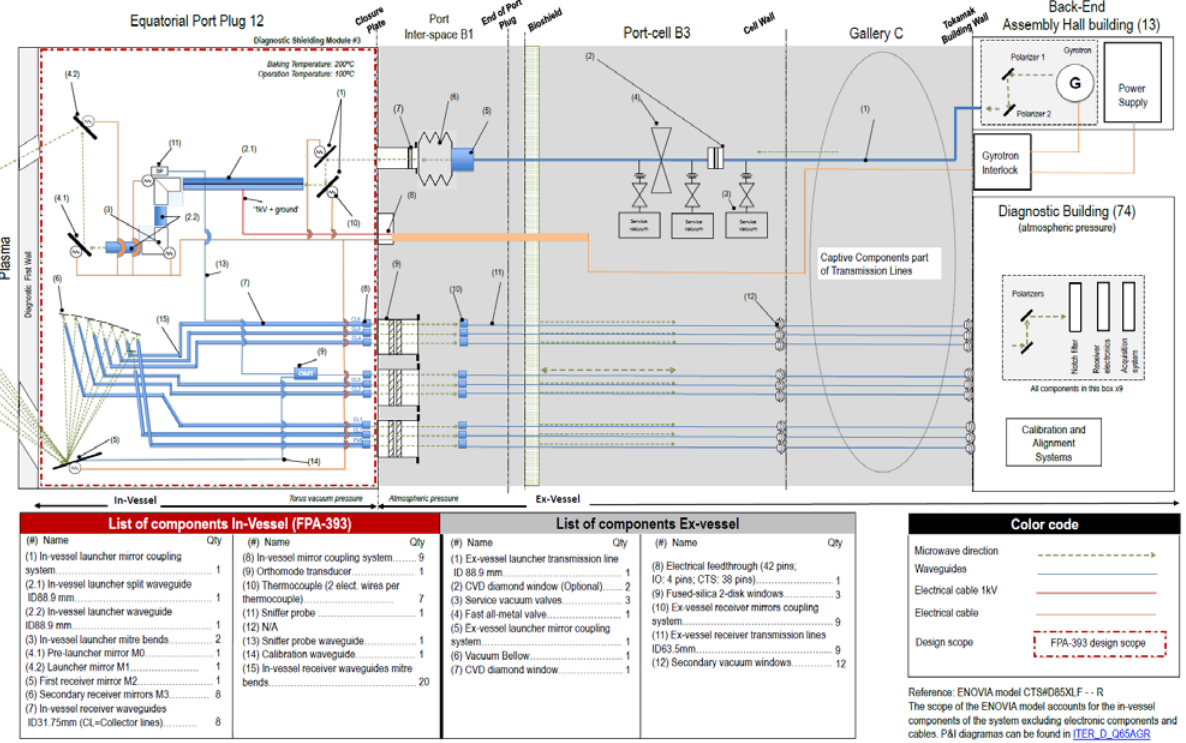
Fig. 1. Schematic for the ITER CTS